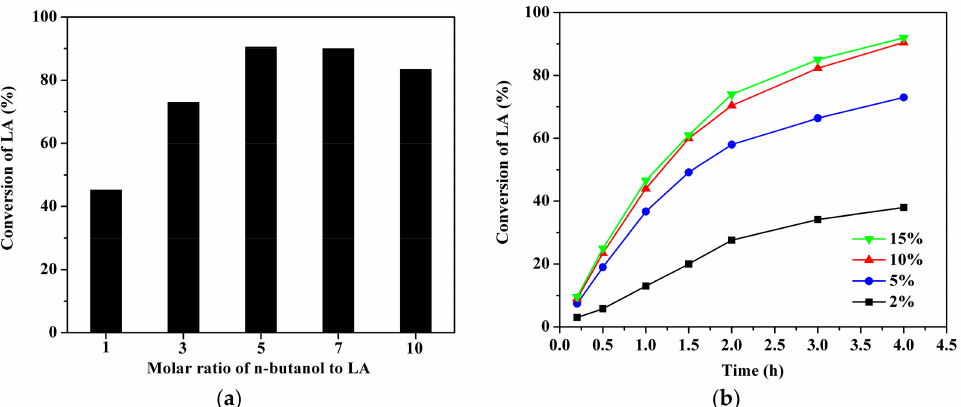
Figure 6. Conversions of LA over GC400 as the function of molar ratio of n-butanol to LA ( a ) or as the function of catalyst loading ( b ). Reaction conditions: ( a ) 1.16 g LA, 0.116 g catalyst, 373 K, 4 h; ( b ) 1.16 g LA, 3.7 g n-butanol, 373 K, 4 h.